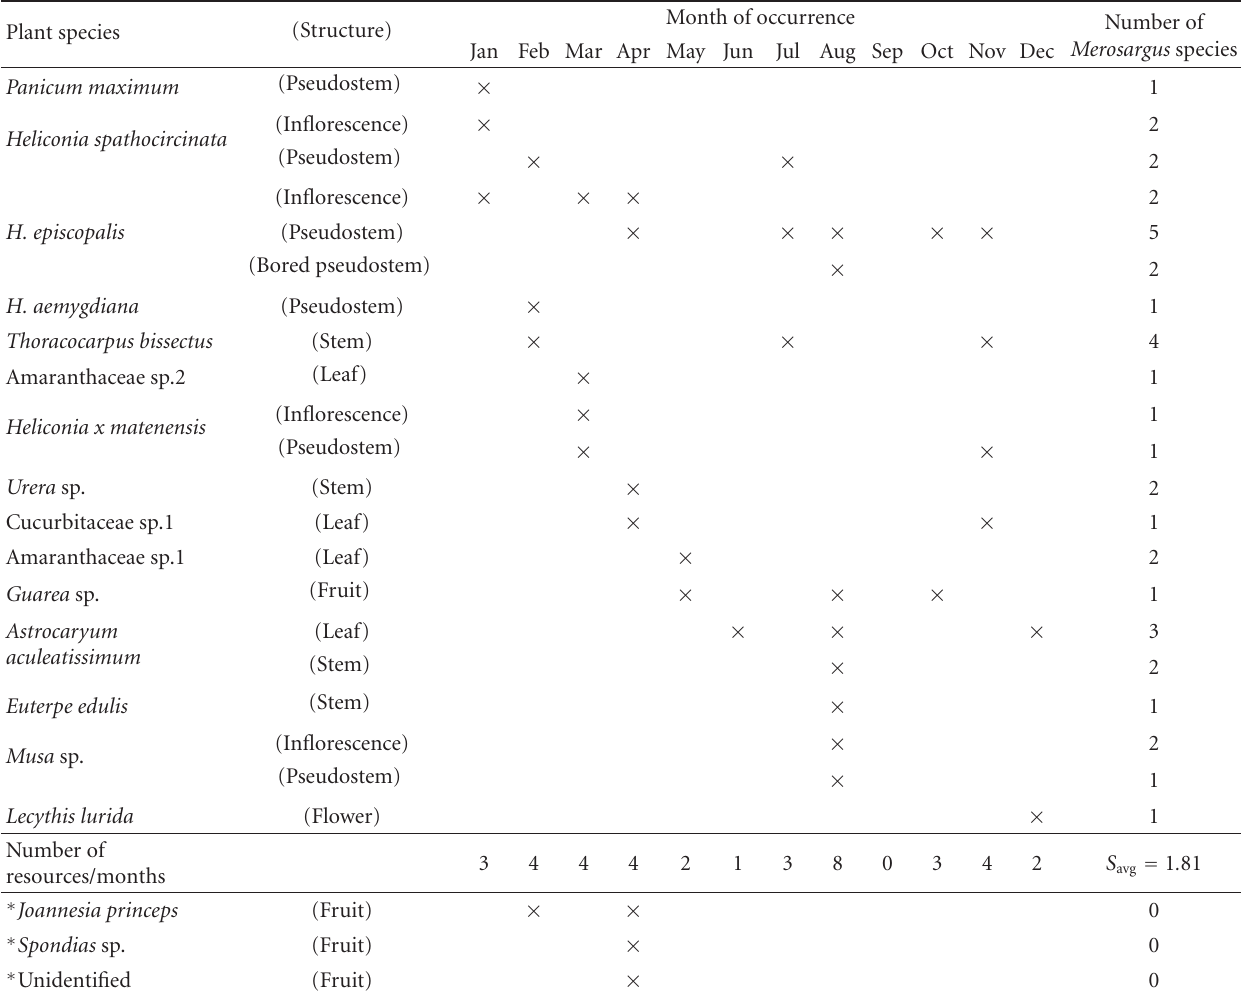
Table 1: Plant species and structure used as a resource by Merosargus larvae, month of occurrence, and number of Merosargus species found in samples collected at the Parque Estadual do Rio Doce (PERD), Minas Gerais, Brazil, between October 2001 and October